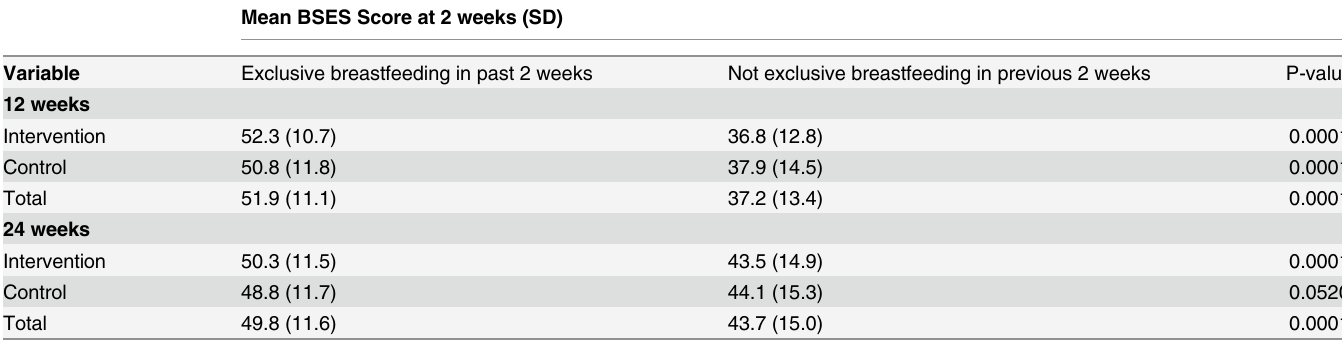
Table 8. Association between BSES scores and the primary outcome. Mean BSES Score at 2 weeks